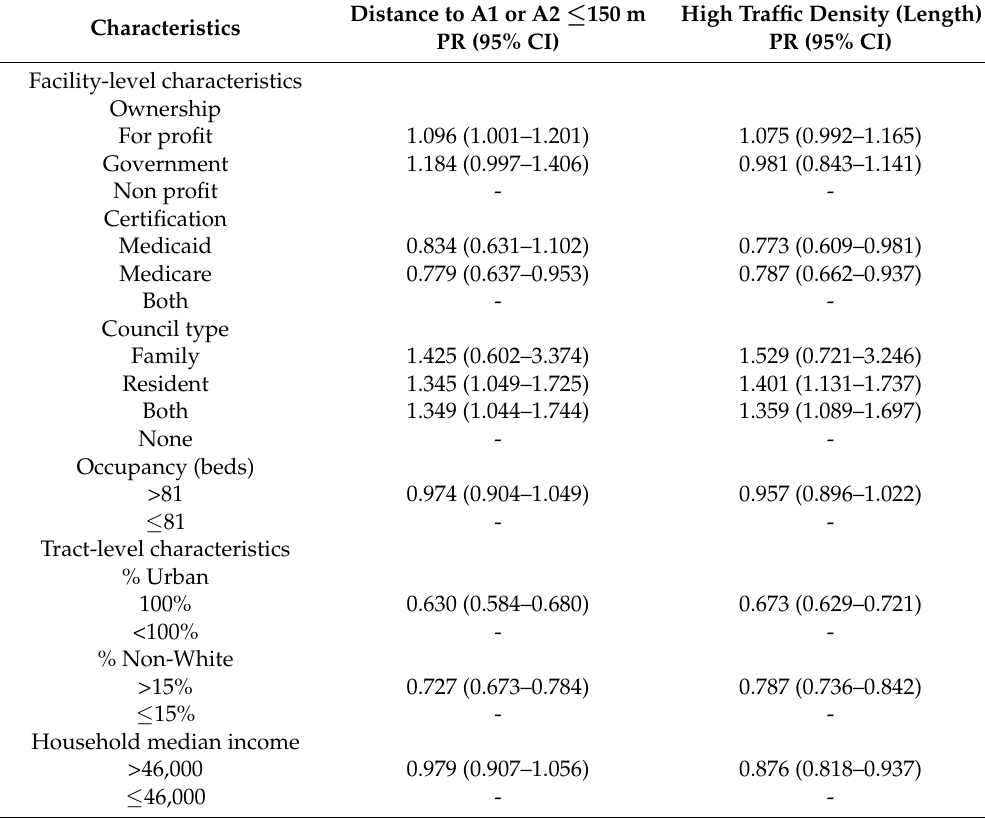
Table 2. Prevalence ratios of facility- and census-tract-level characteristics associated with being located within 150 m of major roadways (A1 or A2) and exposure to high traffic density (length) within 300 m buffer of major roadways (A1 or A2) *.